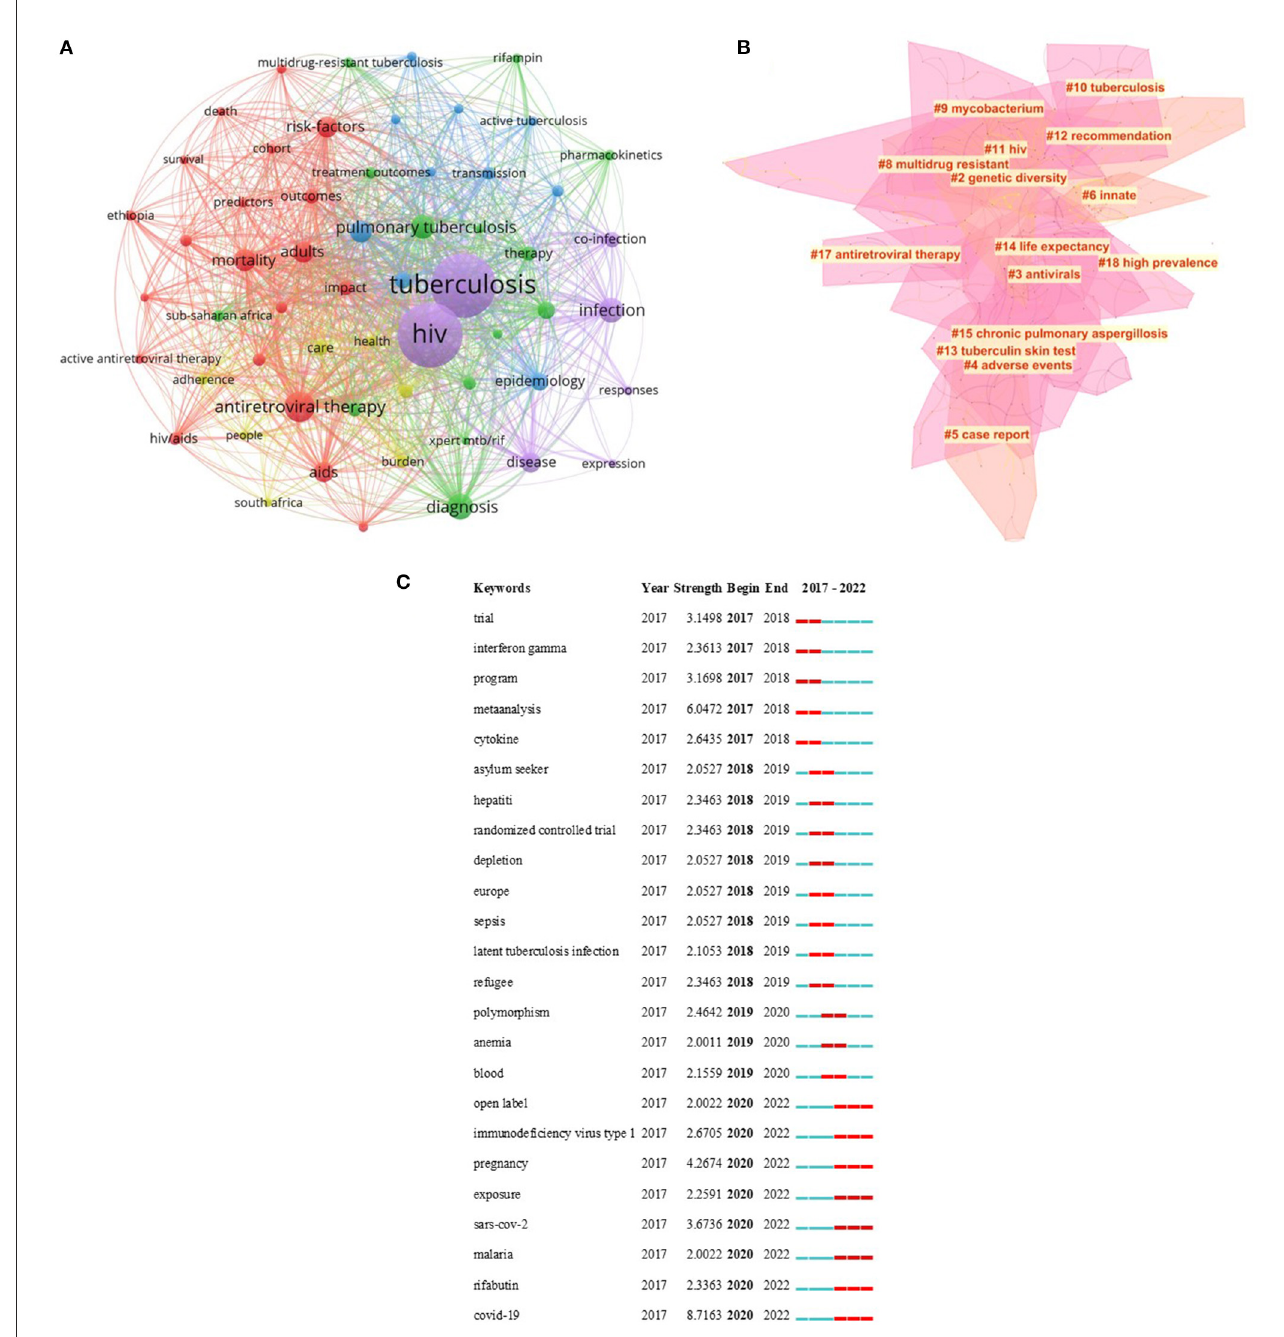
FIGURE5 Analysis of keywords on HIV-MTB co-infection. (A) The co-occurrence analysis of keywords on HIV-MTB co-infection. (B) The cluster map of keywords on HIV-MTB co-infection. (C) The burst keywords of keywords on HIV-MTB co-infection. The nodes represent the keywords. The depth of color represents the topic of keywords. The size of the dot represents the number of keywords. The thickness of the connecting lines represents the strength of the correlation in the keywords.